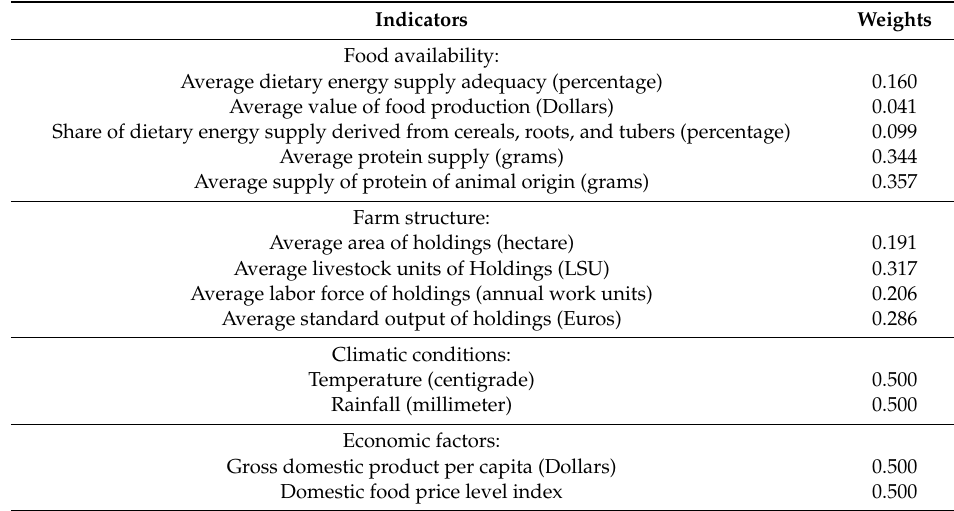
Table A1. The obtained weights of the indicators through factor analysis; Source: own calculations.